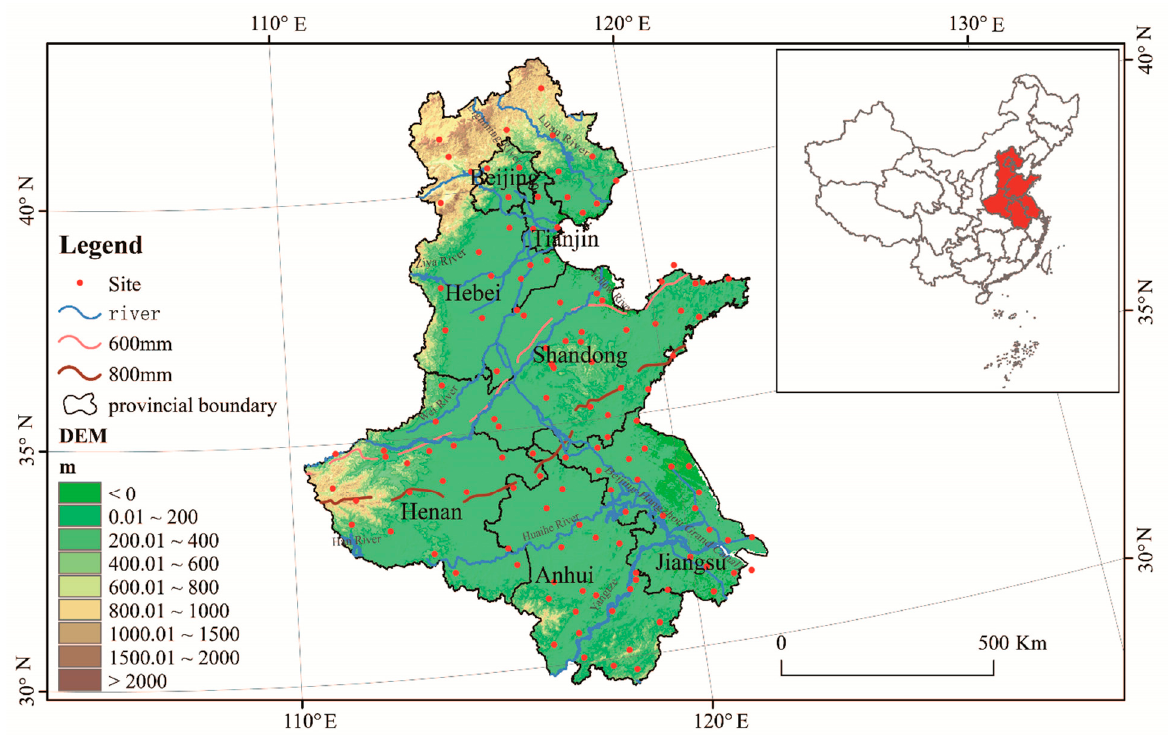
Figure 1. Study area of the North China Plain region with red dots illustrating meteorological stations.